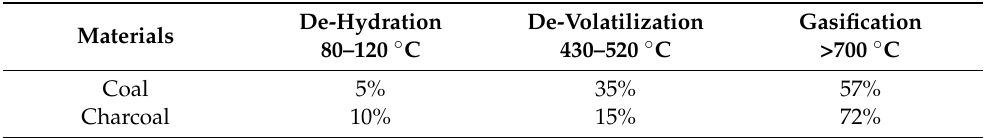
Table 3. Behaviors of charcoal and coal in CO 2 atmosphere heating up to 1100 ◦ C from the room temperature.